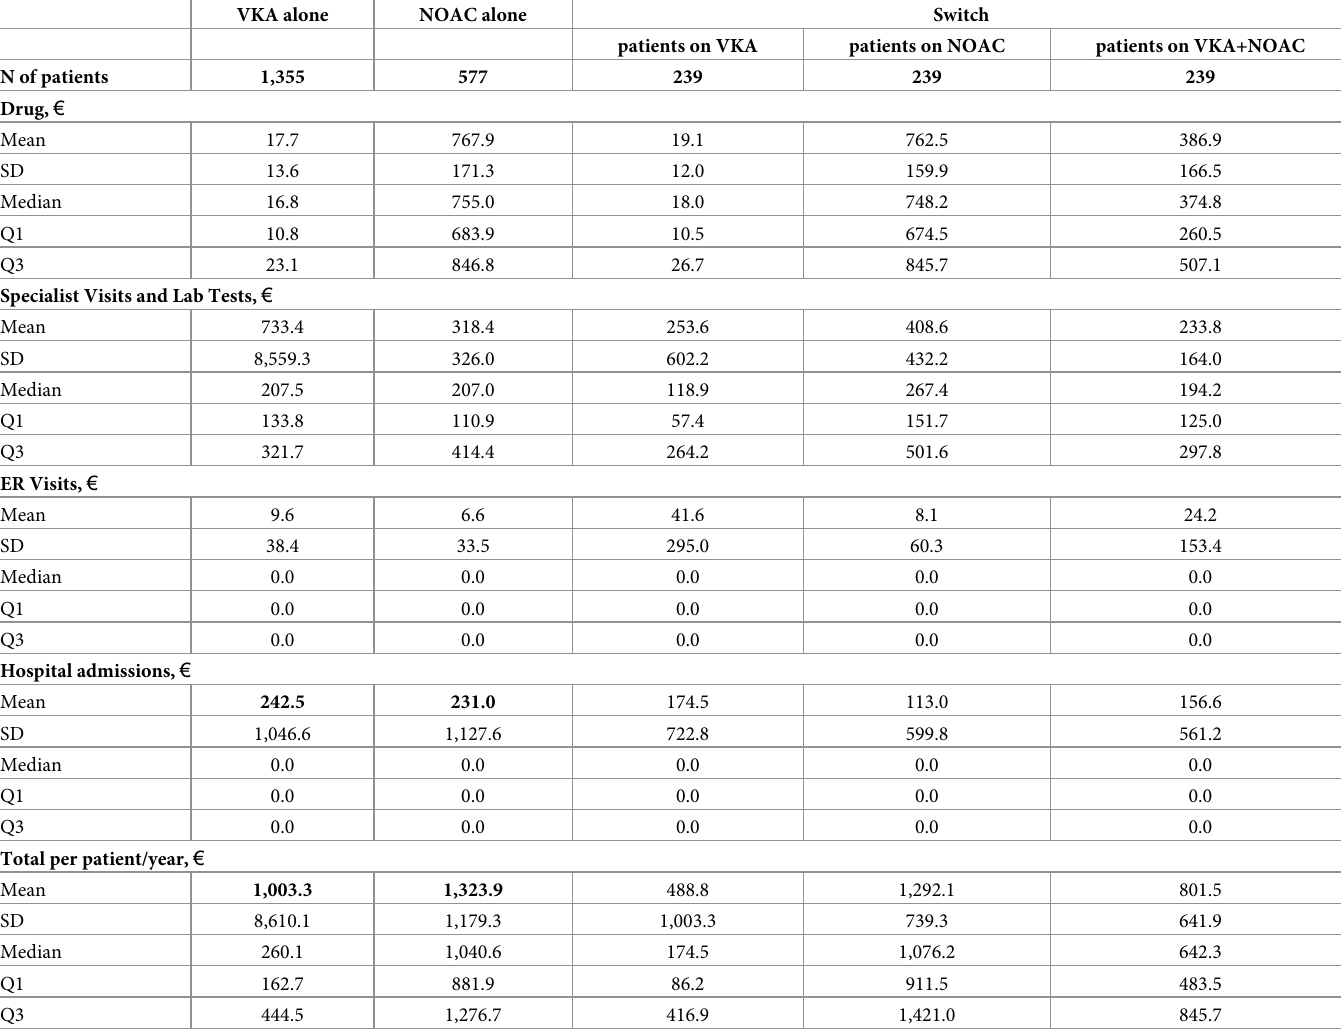
Table 4. Cost analysis: Mean cost per patient/year over study follow-up (VKA: VKA Group—NOAC: NOAC Group). VKA alone NOAC alone